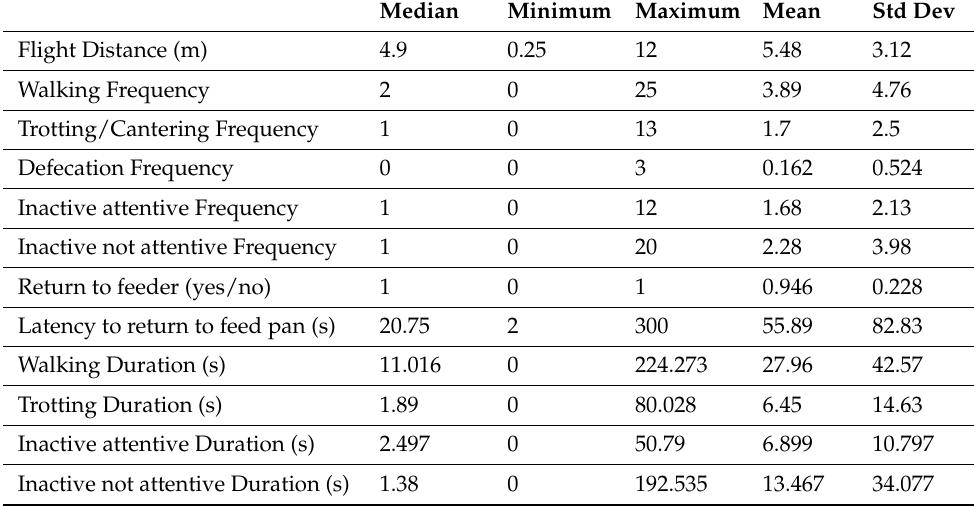
Table 2. Descriptive statistics of behavioral variables for startle